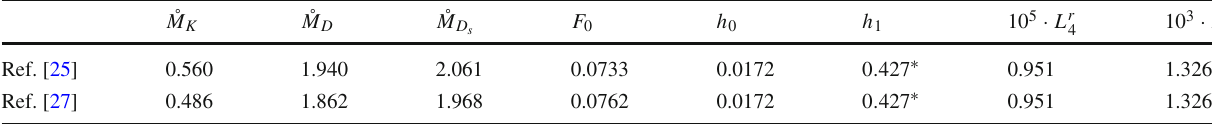
Table 2 Parameters for the chiral extrapolation for different configurations. h 0 , L r constant in the chiral limit are in units of GeV. h 0 , h 1 , L r